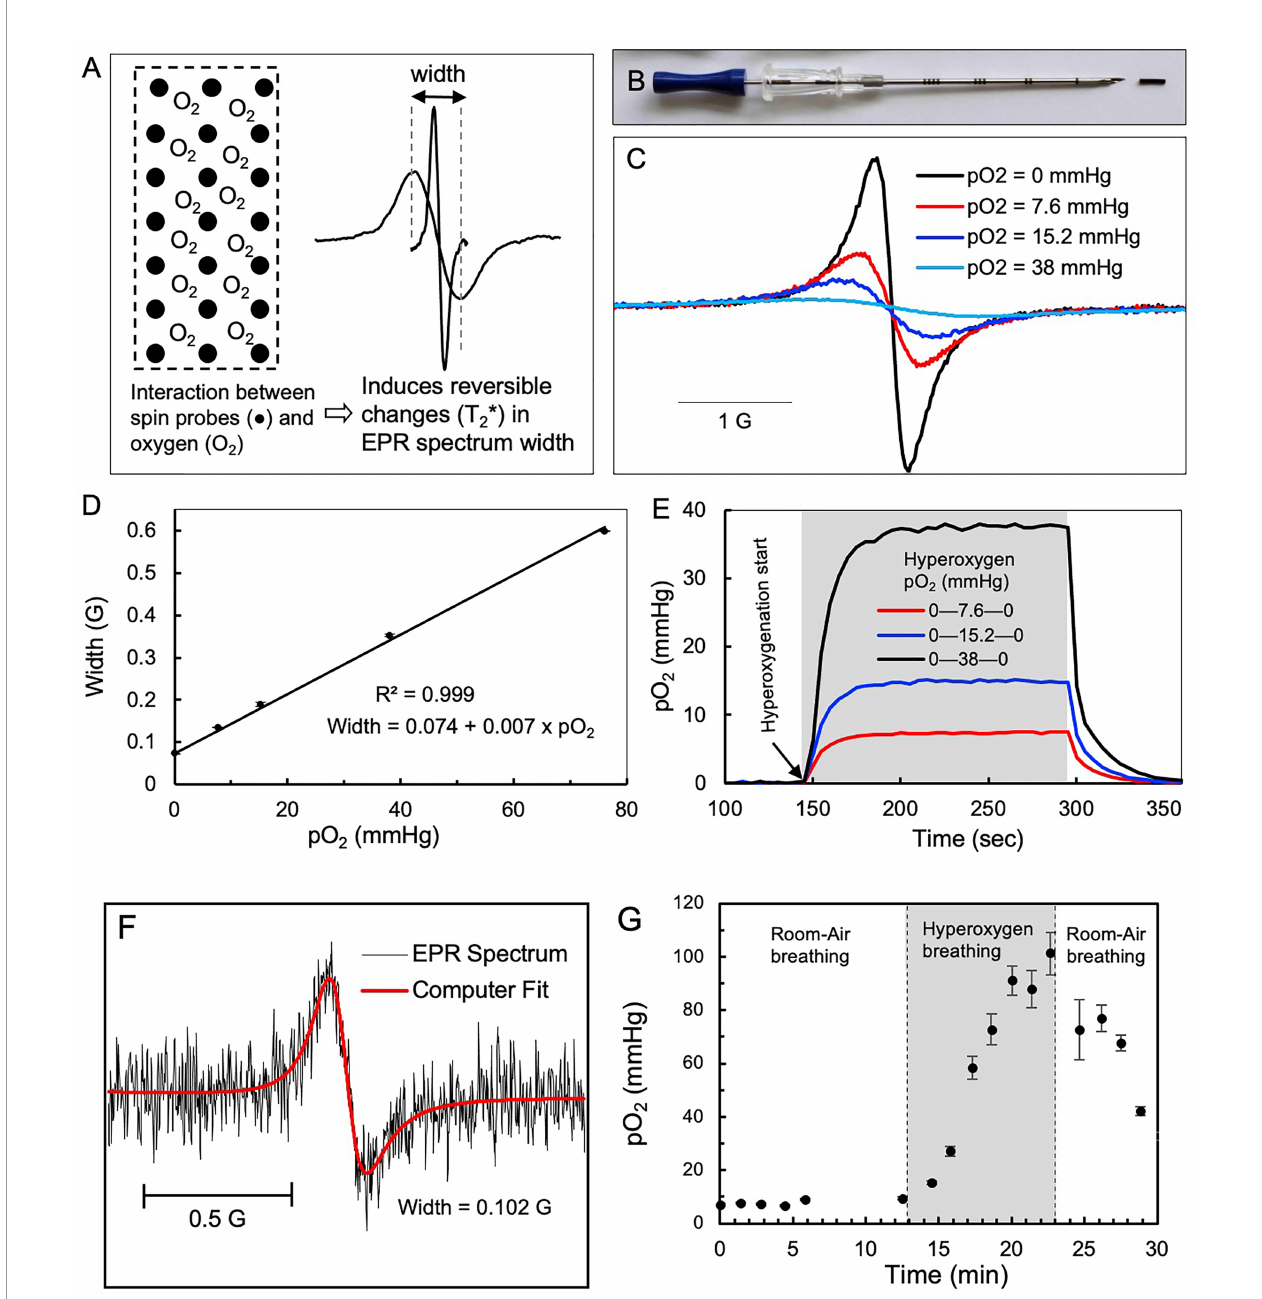
FIGURE 1 | EPR oximetry using OxyChip. Oxygen (pO 2 ) measurements in tumors were made by EPR oximetry using the OxyChip. (A) Illustration of the principle of EPR oximetry using the OxyChip. (B) Photograph showing an OxyChip along with a brachytherapy needle used for implantation in tumors. (C) EPR spectra of an OxyChip obtained in vitro in the presence of different oxygen levels (pO 2 in mmHg): 0, 7.6, 15.2, and 38 at room temperature. The spectra exhibit oxygen-dependent broadening. (D) EPR width of the OxyChip measured in the pO 2 range 0 – 76 mmHg at room temperature. The data (mean ± SD; n=5) exhibit a linear response of EPR width to pO 2 . (E) Time-response of the OxyChip to changes in pO 2 levels obtained in vitro . For all pO 2 levels (in mmHg) baseline measurements were obtained at 0, hyperoxygenation was initiated (gray block: 7.6; 15.2; and 38 mmHg), and then oxygen was discontinued with a return to baseline (0)mmHg. The data indicated a time-response of about 30 sec to reach equilibrium in each case. (F) Representative EPR spectrum, computer fi tting, and estimated EPR spectral width obtained from the tumor of a patient (20 in Table 1 ). Superimposed in red is a computer fi t used to obtain spectral width, which was converted to pO 2 using a calibration curve (D) . (G) Representative pO 2 data obtained from a patient (9 in Table 1 ) during a session of room-air breathing, hyperoxygen breathing (gray block) and return to room-air